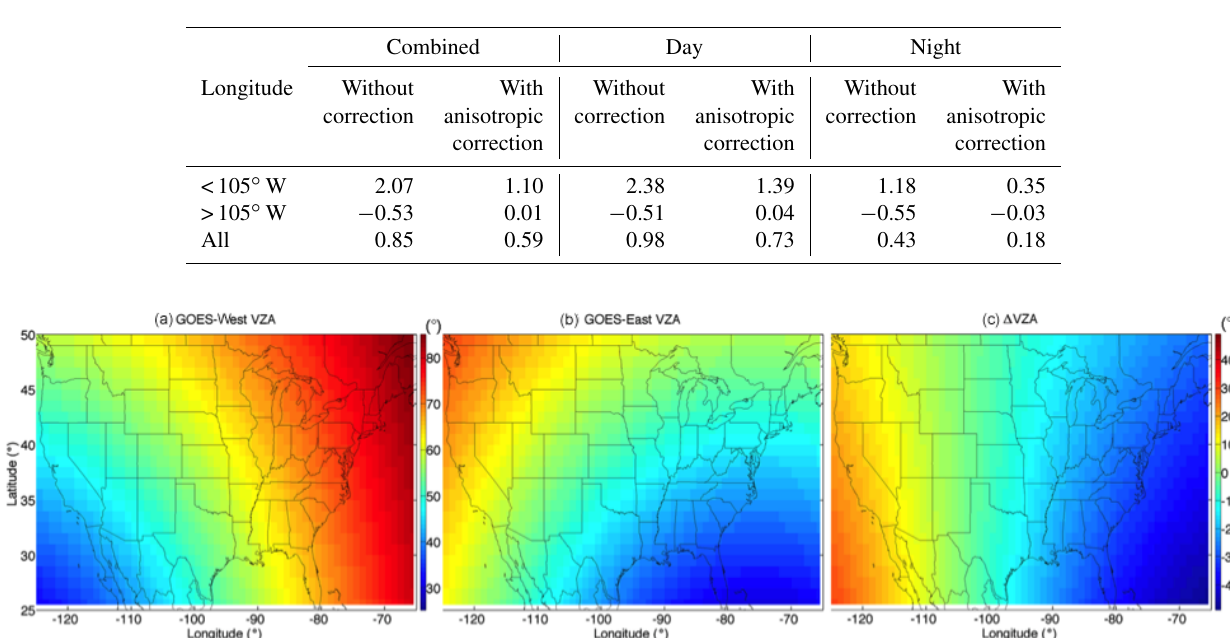
Table 1. July 2013 day, night, and combined matched GOES-East minus GOES-West mean clear-sky surface skin temperature difference (K) for regions east and west of 105 ◦ W, without and with anisotropic correction. The sample-weighted average bias is shown in the bottom row.